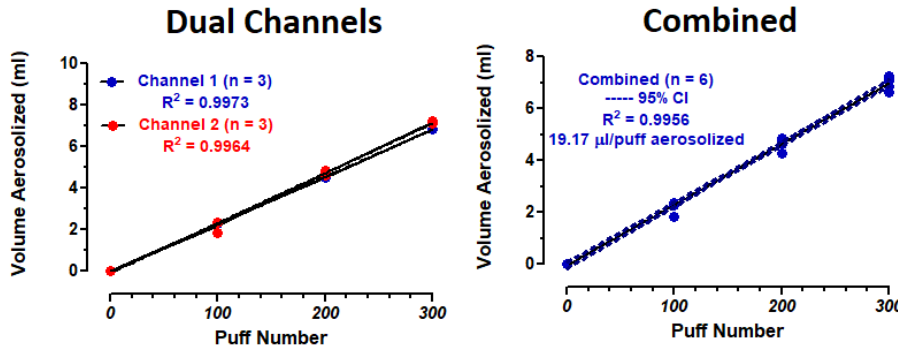
Figure 10. The volume of E-liquid aerosolized on a per puff basis using the ECIG aerosol generator.